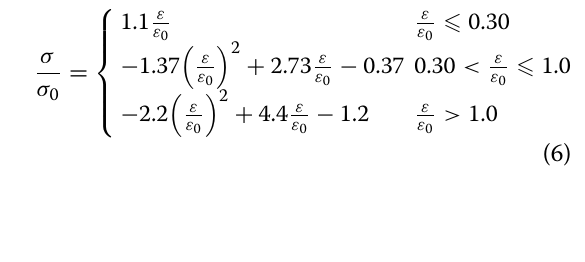
pressive stress. Figure 11 shows that the fitting curve is in good agreement with the standardized stress–strain relationship measurement points of the CNACBM specimens.